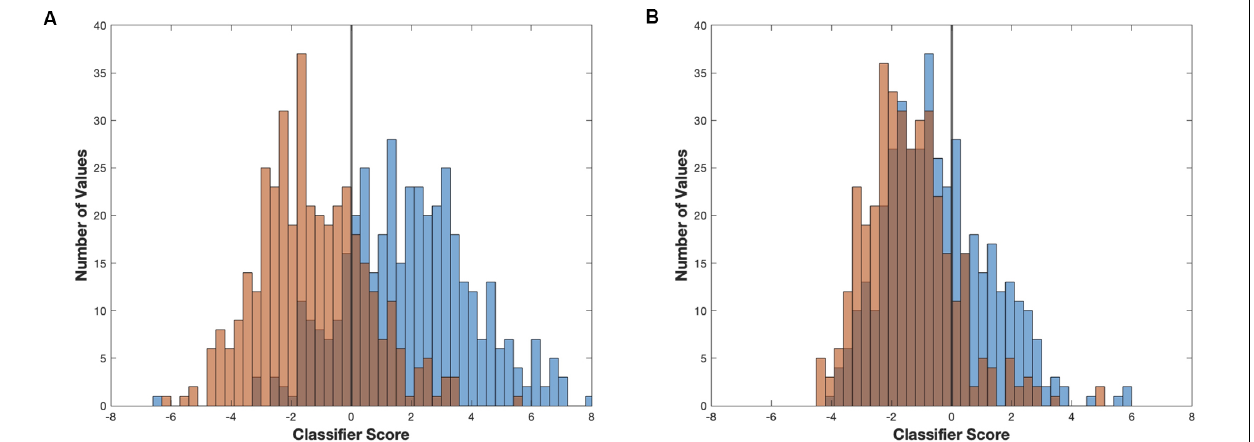
FIGURE 7 | Linear classifier accuracy determines maximum separability of two signals. Two examples of linear classifiers demonstrating how classifier differentiation can vary in effectiveness at separating two signals. Examples using linear classifier models and resulting scores generated from (A) the first 2,000 s of induction (blue) and emergence (red) from mouse 2 (higher accuracy/effectiveness,) and (B) the final 2,000 s of induction (blue) and emergence (red) from mouse 1 (low/chance